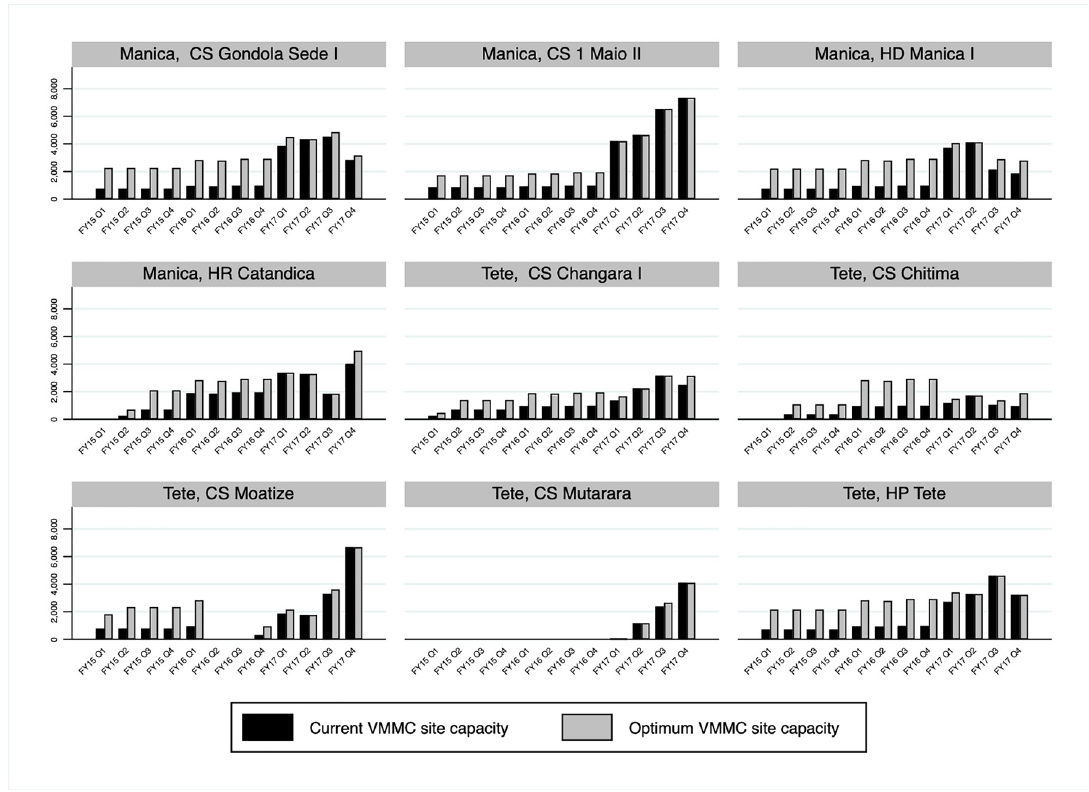
Fig 5. Current voluntary medical male circumcisions (VMMCs) site targets and optimum VMMC site capacity in Manica and Tete, Mozambique FY15 Q1- FY17 Q4 by fixed service delivery